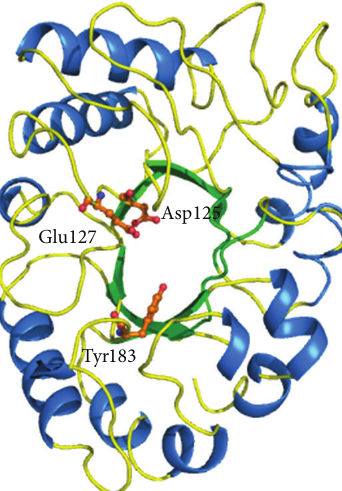
Figure 10: Overall structure of hevamine showing TIM barrel domain and the catalytic residues (in